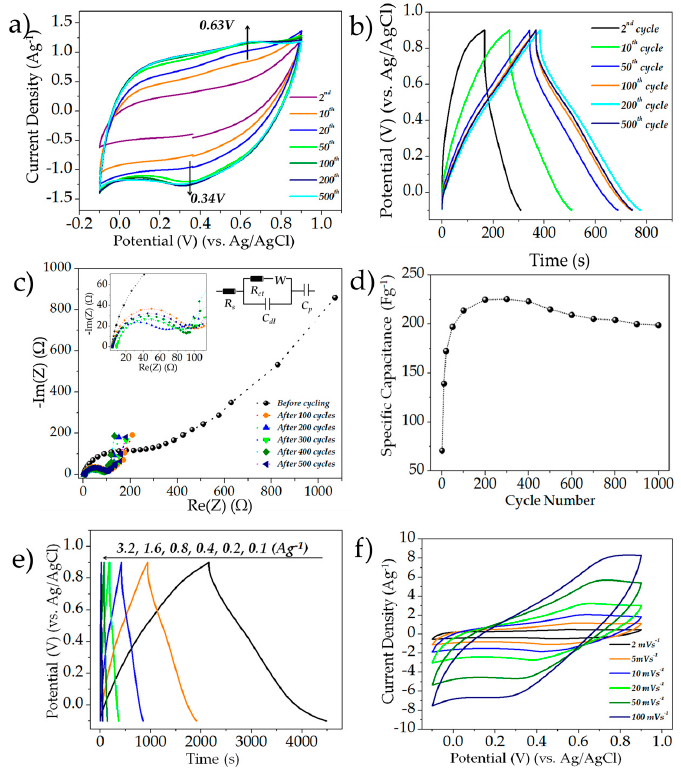
Figure 3. ( a ) CV curves of the MnO x films at different cycles scanned at a sweep rate of 5 mV ∙ s − 1 ; ( b ) typical GCD curves of the MnO x films at a constant charge-discharge current rate of 0.5 Ag − 1 for different cycles; ( c ) Nyquist plots of the MnO x films at different cycles; the inset depicts the equivalent circuit used for system analyses; ( d ) cycling behavior of the MnO x films; ( e ) galvanostatic charge-discharge profiles of the MnO x films at different current rates; ( f ) CV curves at different sweep rates (2–100 mV ∙ s − 1 ).